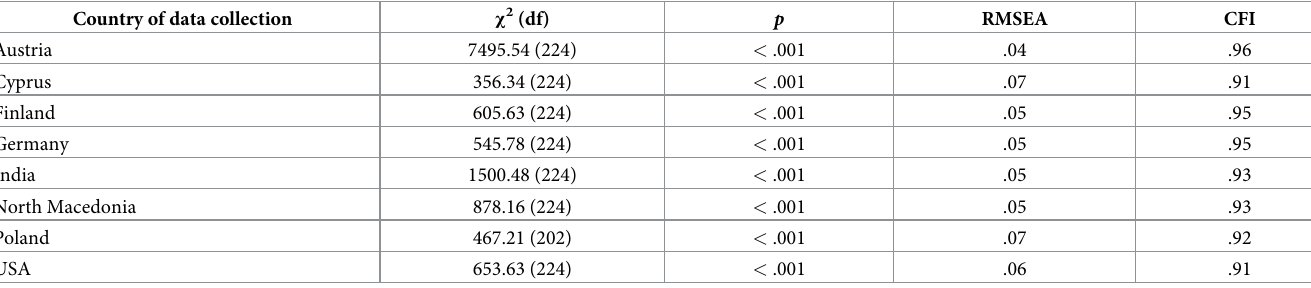
Table 3. Model fit indices of the measurement models for each country of data collection. Country of data